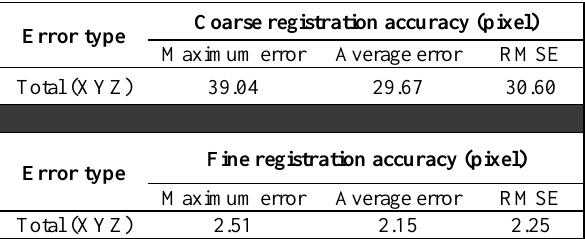
Table 2. average, RMSE and maximum errors before and after applying developed method The total RMSE of the initial coarse registration is 30.60 pixels which is decreased to 2.25 pixels. Average registration accuracy decreased to 2.15 pixels. Furthermore, maximum error on the check point C4 equals to 2.51 pixels. As an overall result, horizontal result of the photogrammetric network is more accurate than vertical one.